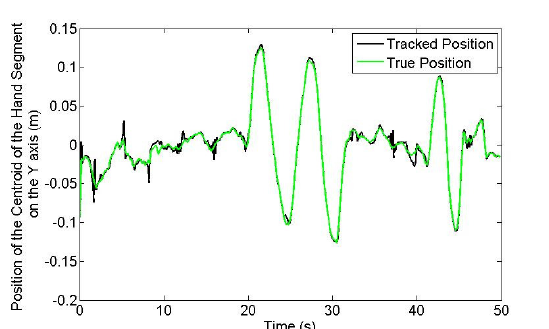
Figure 2. Evaluation of the tracking method: Comparison between tracked and true positions of the hand centroid On the Y axis